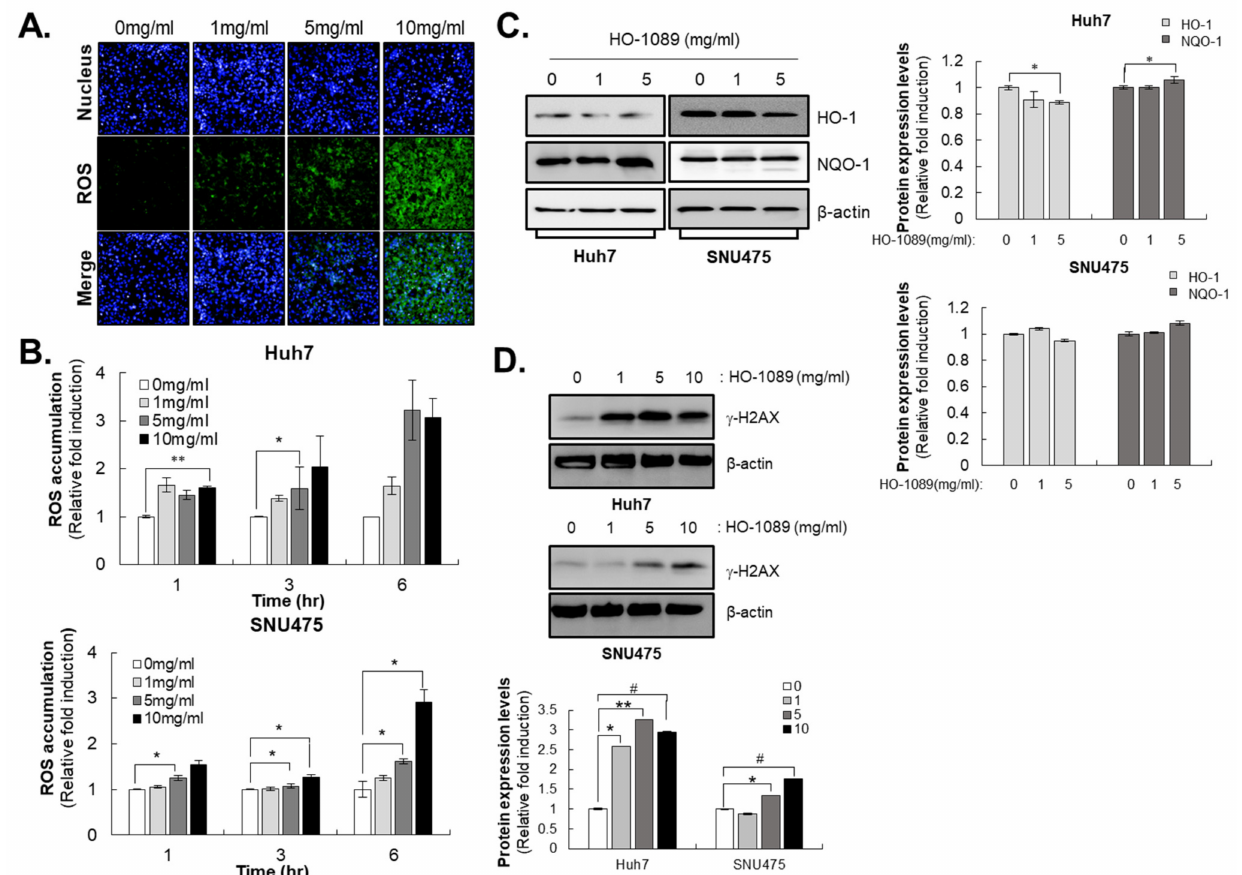
Figure 2. DNA damage by ROS accumulation induced by HO-1089 treatment: ( A , B ) Huh7 cells were treated with HO-1089 concentrations of 0, 1, 5, or 10 mg/mL for 24 h. ROS were detected with CM- H 2 DCFDA staining and analyzed using an HCS system. ROS intensity was measured and calculated. ( C ) The expression of antioxidant-related proteins was examined in 0, 1, or 5 mg/mL HO-1089-treated Huh7 and SNU475 cells (left panel). The Western blot images were quantitatively analyzed (right panel). ( D ) DNA damage-related protein, r-H2AX, was detected in 0, 1, 5, or 10 mg/mL HO-1089- treated Huh7 and SNU475 cells (upper panel). The Western blot images were quantitatively analyzed (lower panel). Results were normalized to control values to obtain values for relative fold